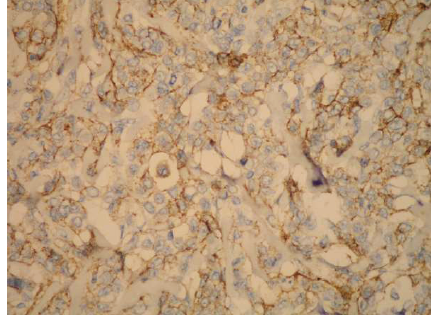
Figure 2: Moderate epithelial Sdc1 expression in the ILC (IHC, × 200).